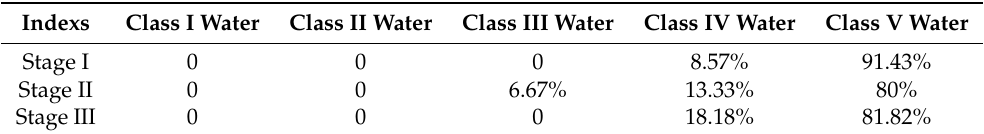
Table 3. Statistical results of fuzzy comprehensive evaluation of karst groundwater in Taiyuan